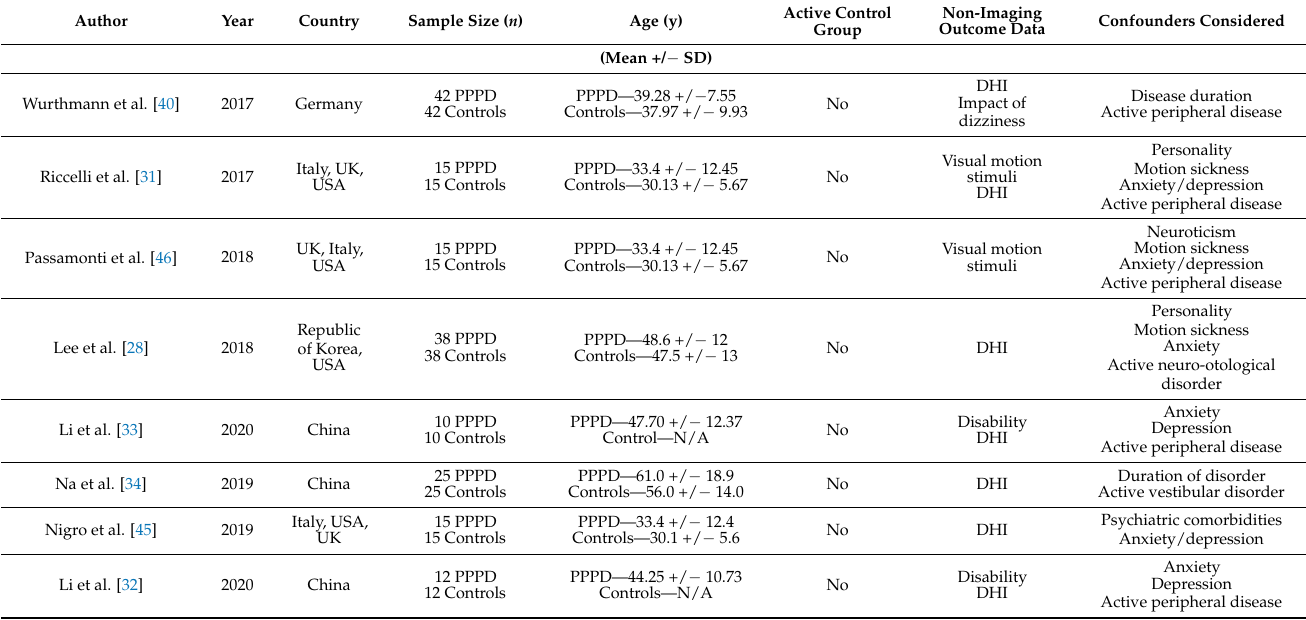
Table 1. Summary of the data extraction from n = 8 articles focusing on pathophysiology of persistent postural-perceptual dizziness (PPPD) using brain imaging